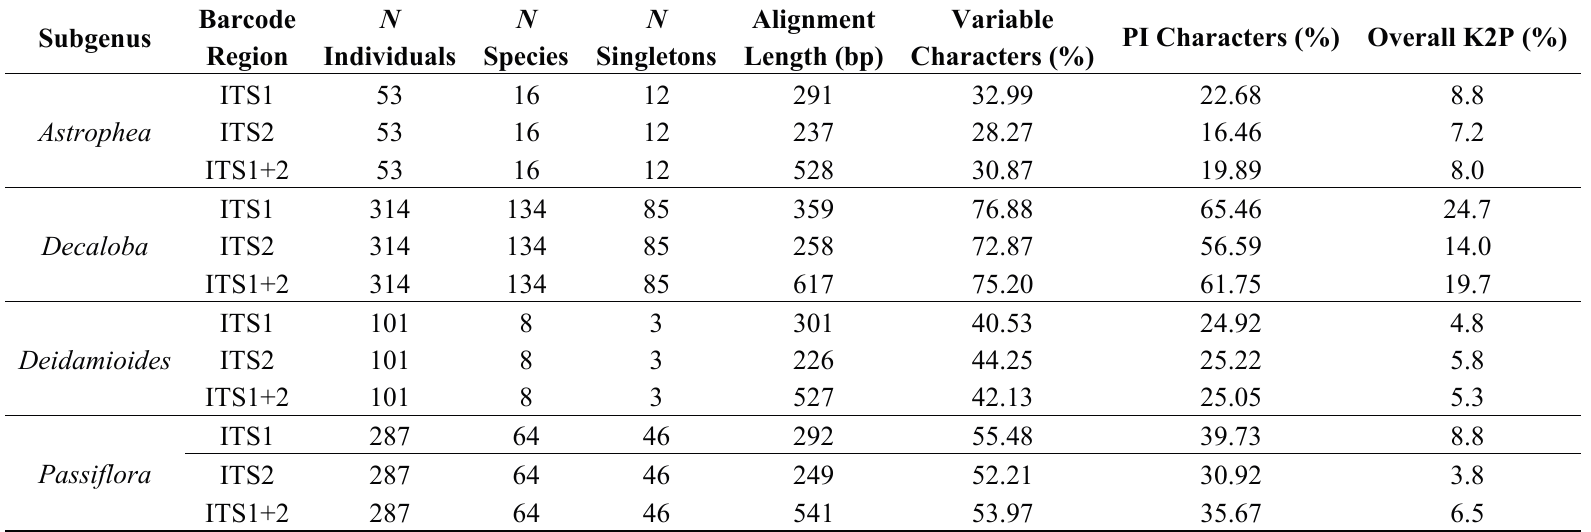
Table 1. Characteristics of each internal transcribed spacer (ITS) dataset presented per